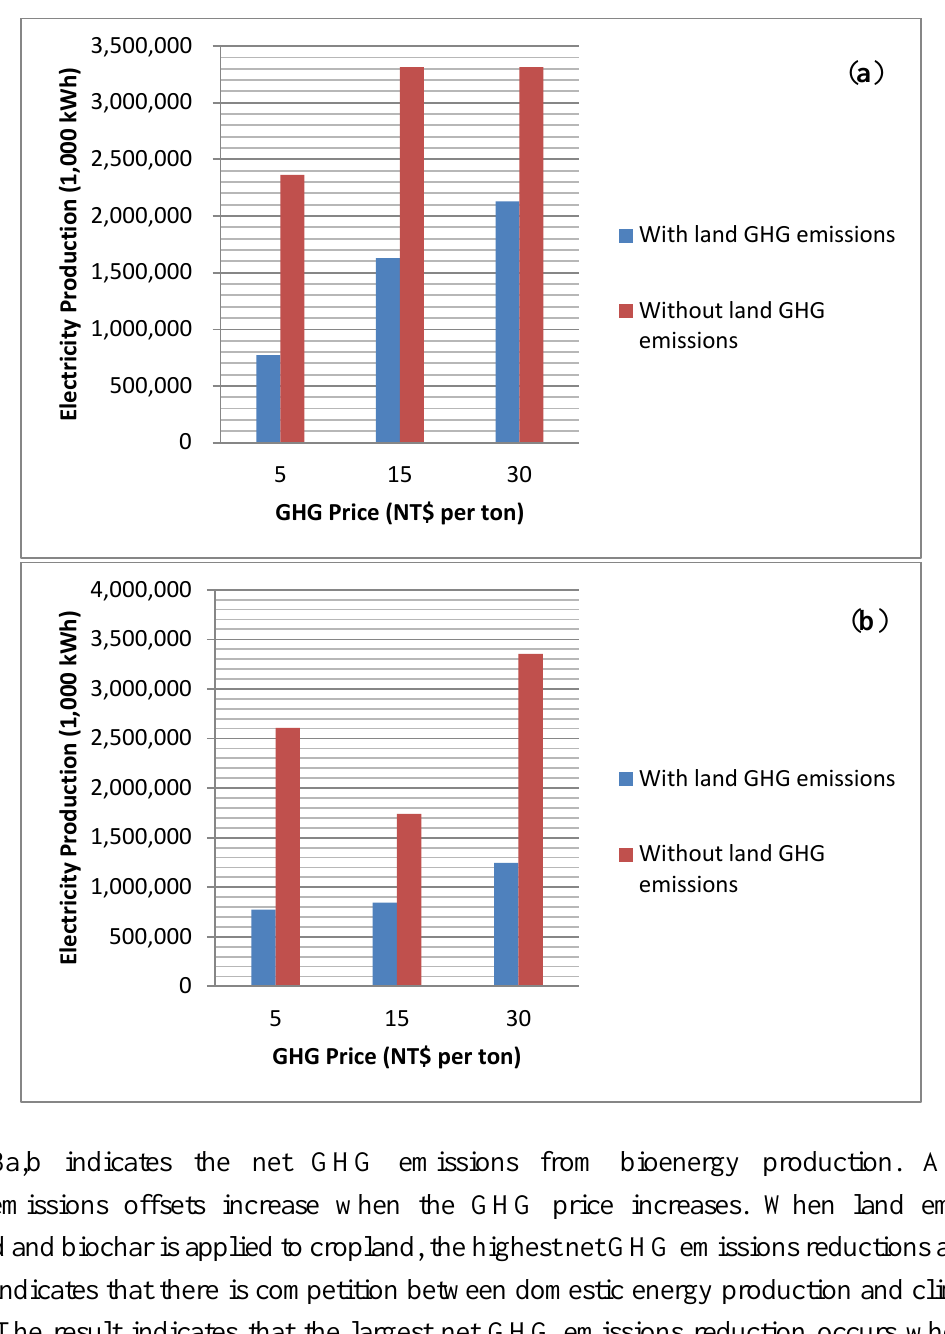
( a With land GHG emissions Without land GHG